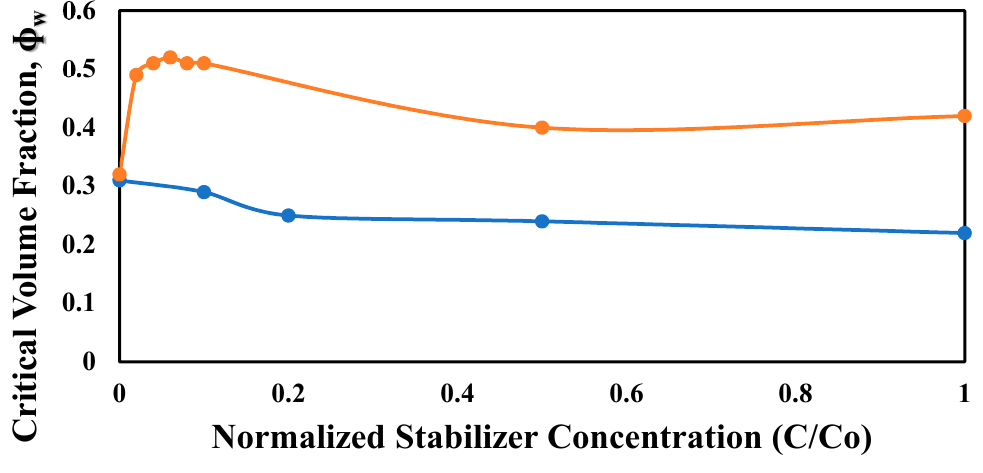
Figure 13. Aqueous phase critical volume fraction as a function of normalized concentration for CTAB and nanoclay.